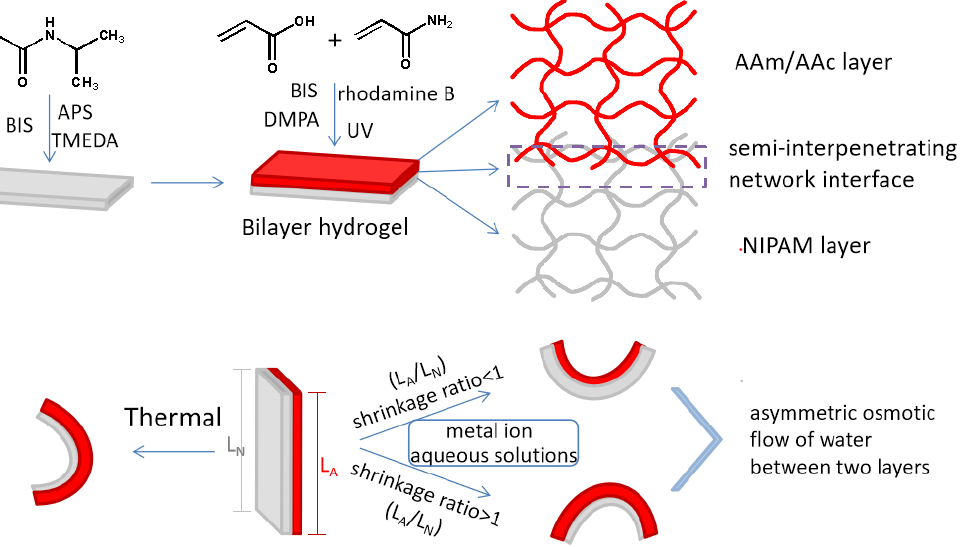
Figure 1. Preparation of the bilayer hydrogel actuator and illustration of the shape-morphing behavior activated by heat or metal ions.